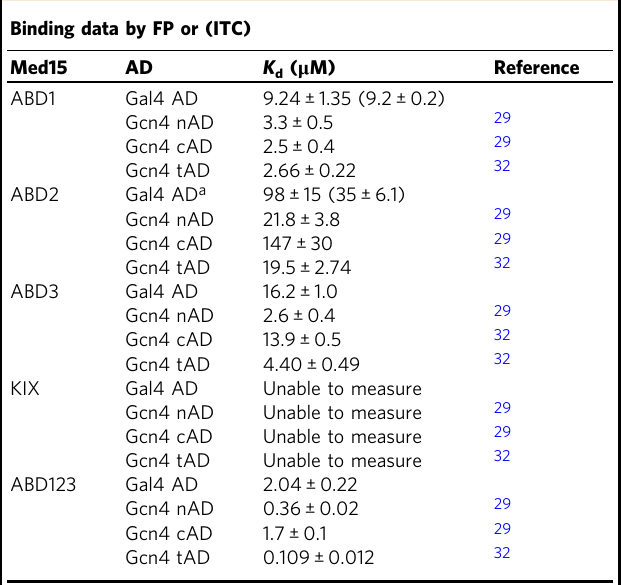
Table 1 Af fi nity of ADs for Med15 activator-binding